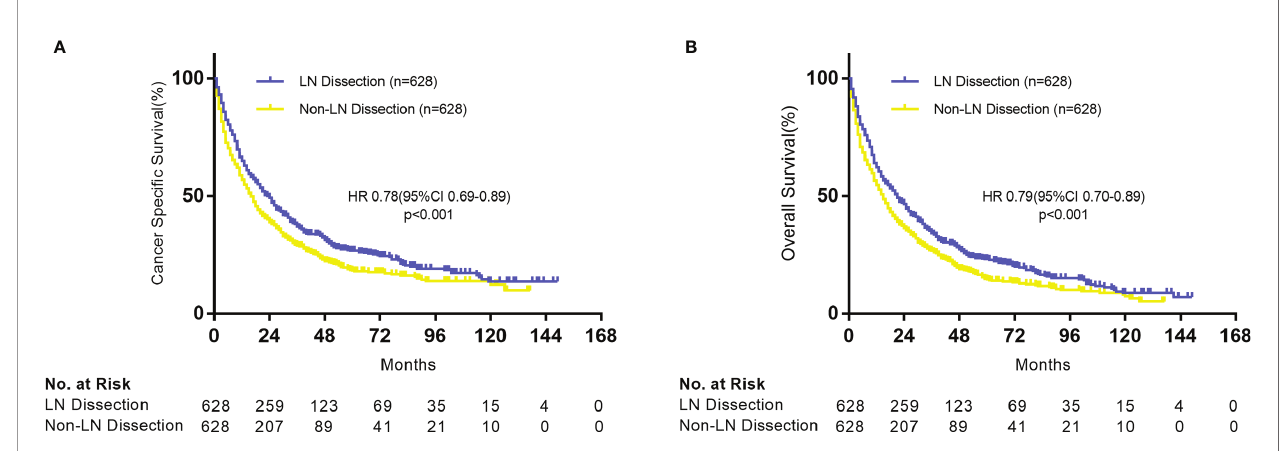
FIGURE 2 | Kaplan – Meier plot of survival outcomes for patients with stage IV NSCLC according to lymph node dissection. (A) Cancer-speci fi c survival. (B)